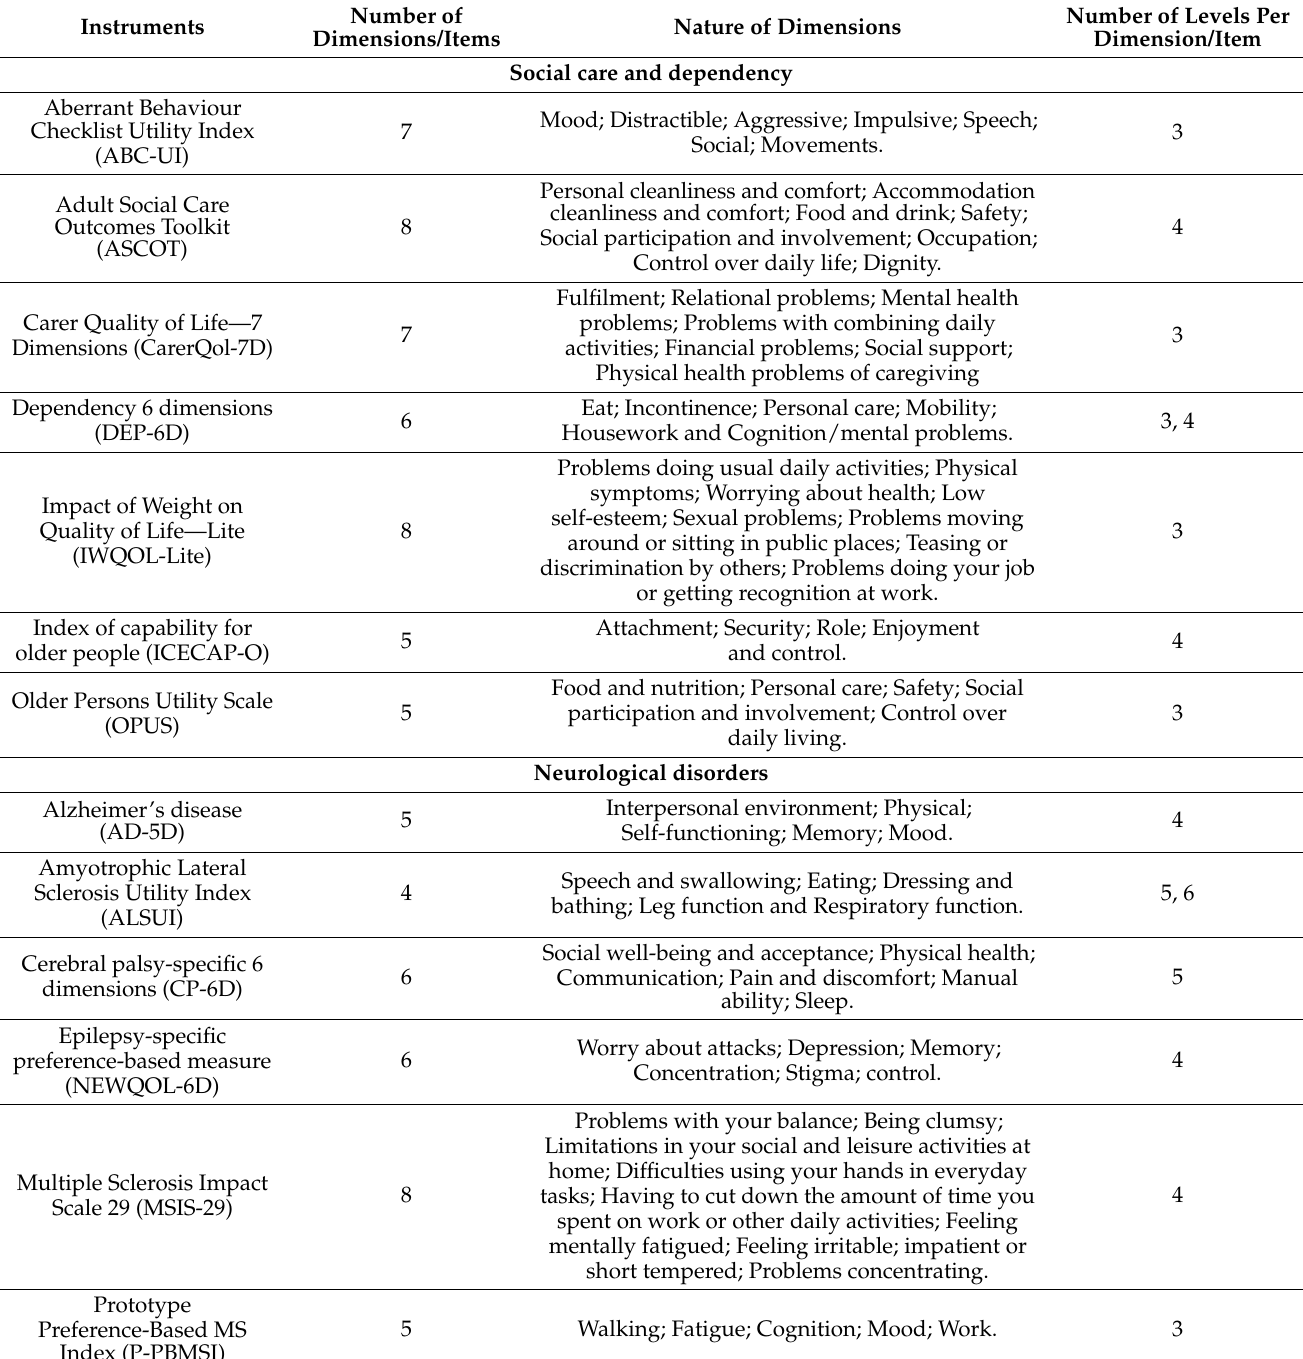
Table 3. Dimensions and levels selected in specific